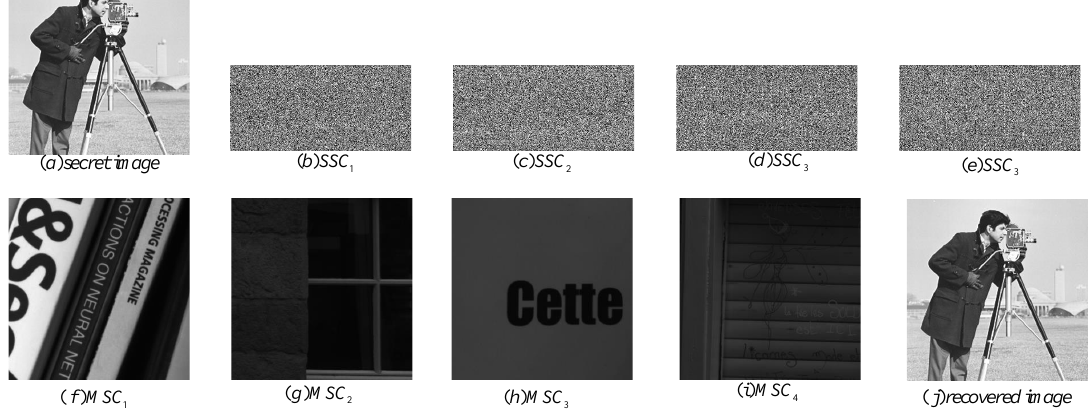
Figure 5. The sharing results of ( 2,4 ) -threshold meaningful Secret Image Sharing scheme (Natural Steganography